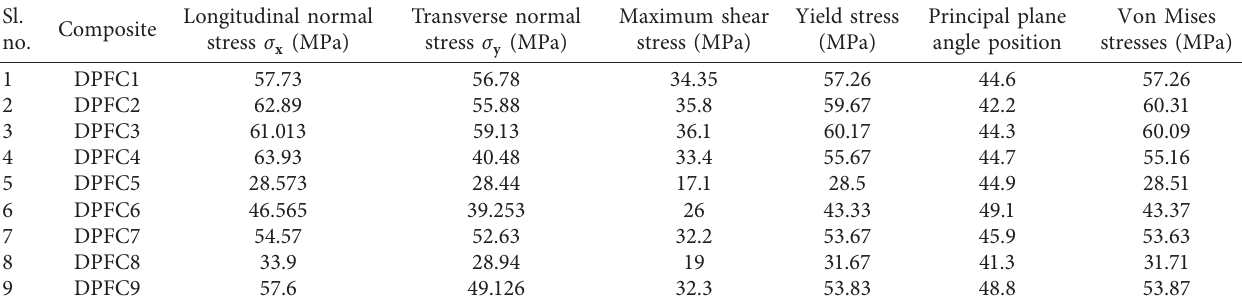
Table 10: Normal stresses, max shear stresses, and principal plane angle for DPF composite normal stresses, max shear stresses, and Von Mises stresses. Sl.